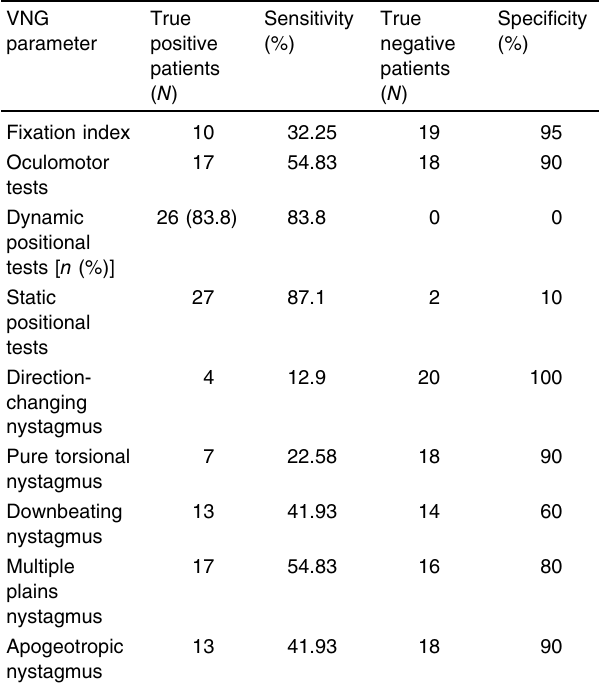
Table 3 Sensitivity and specificity of different videonystagmography parameters VNG